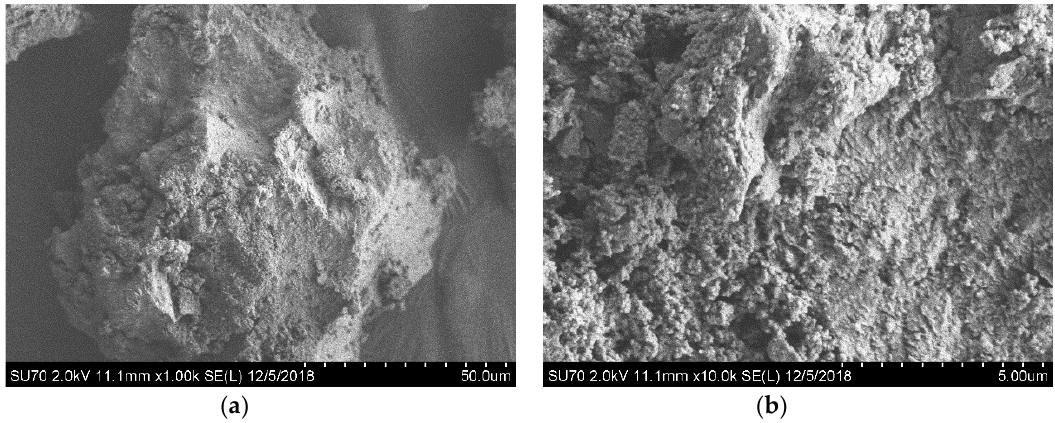
Figure 6. SEM images of MOF-5. Increasing magnification from 1000 × ( a ) to 10,000 × ( b ).